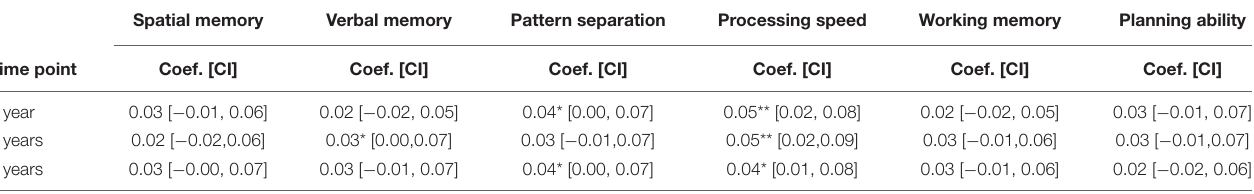
TABLE 8 | Results of the linear regression (Model 3) assessing if CRF at baseline could predict cognitive performance after 1-, 3-, and 5 years of